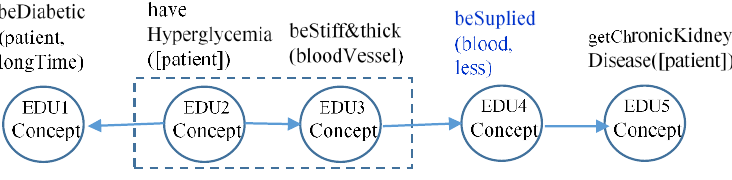
Figure 2. Show causal pathway expressions of Example 3.